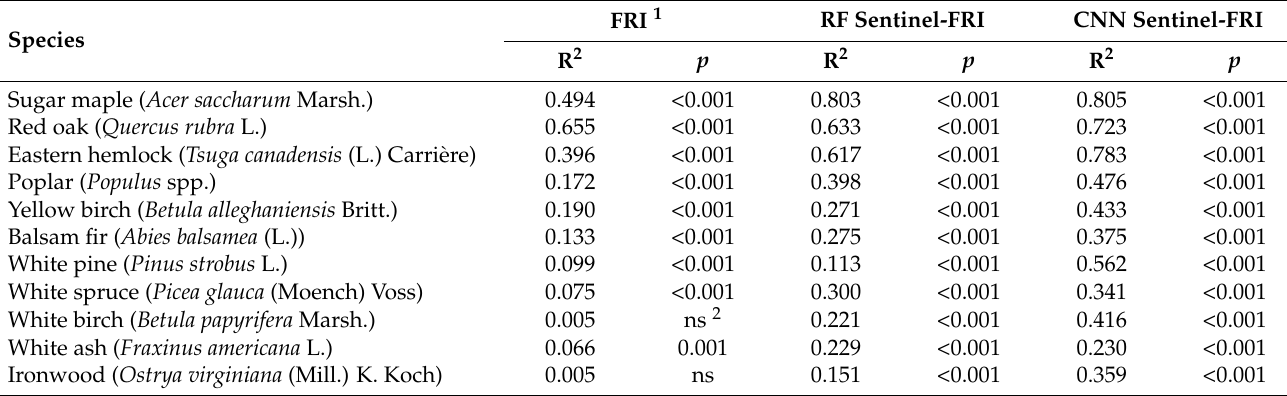
Table 1. Coefficients of determination (R 2 and corresponding p values) between percent basal area of stems >10 cm DBH in 155 0.25-ha field plots and: (1) percent canopy composition in the Forest Resource Inventory (FRI), (2) random forest (RF) predictions, and (3) convolutional neural network (CNN) predictions. The last two were from Sentinel-2-based models trained with FRI information for the entire study area. Species order is based on average R 2 values (highest to